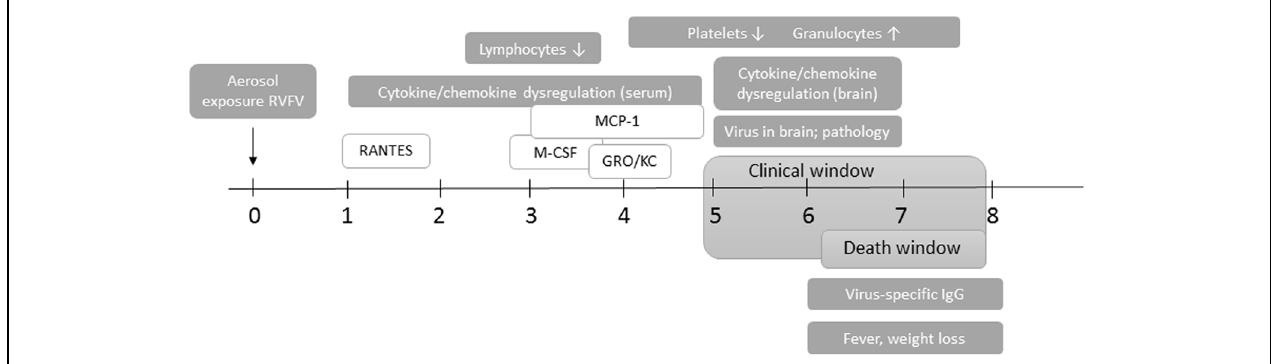
FIGURE 10 | Course of neurological disease in RVFV-infected Lewis rats. Timing of clinical and virological events after aerosol exposure to RVFV. The clinical window is from 5 dpi until death of the rat, and consists of behavioral and appearance changes, weight loss, and fever. Rats succumb to disease between 6 and 8 dpi. Cytokine/chemokine dysregulation in the blood starts as early as 1 dpi (RANTES) and extends to 5 dpi (MCP-1, M-CSF, and Gro/KC). Changes in CBC start at 4 dpi and persist throughout infection. Live virus is found in the brain from 5 dpi onwards, along with significant pathology and cytokine/chemokine dysregulation. Virus-specific antibody responses are not apparent until 6 dpi.